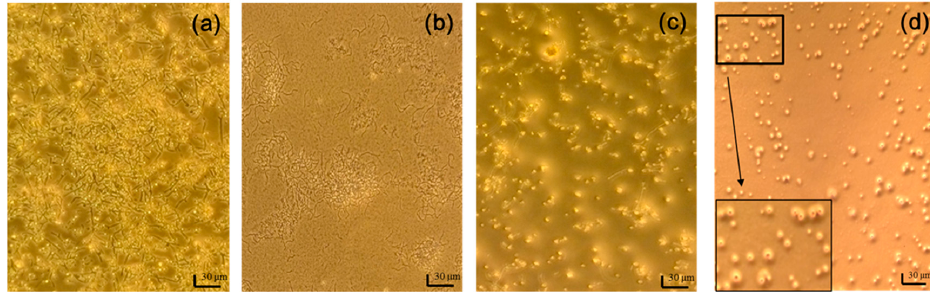
Figure 5. Light images of C. albicans ( a ) before the treatment, and after the treatments with ( b ) 208 μ M fluconazole; ( c ) PDT; and ( d ) combination of fluconazole and PDT. The scale bar represents 30 μ m. The surface features in the black box are enlarged for better visualization.